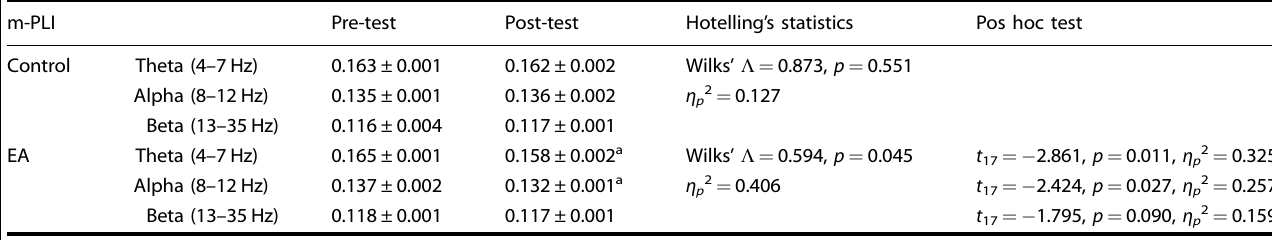
Table 3. The comparison of mean inter-regional connectivity strength (mean phase-lag index (m-PLI)) between the pre-test and post-test for the error ampli fi cation (EA) and control